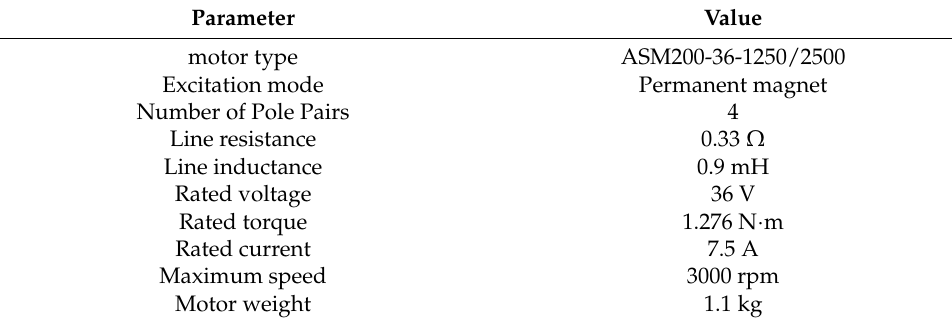
Table 6. Acceleration and deceleration method measurement